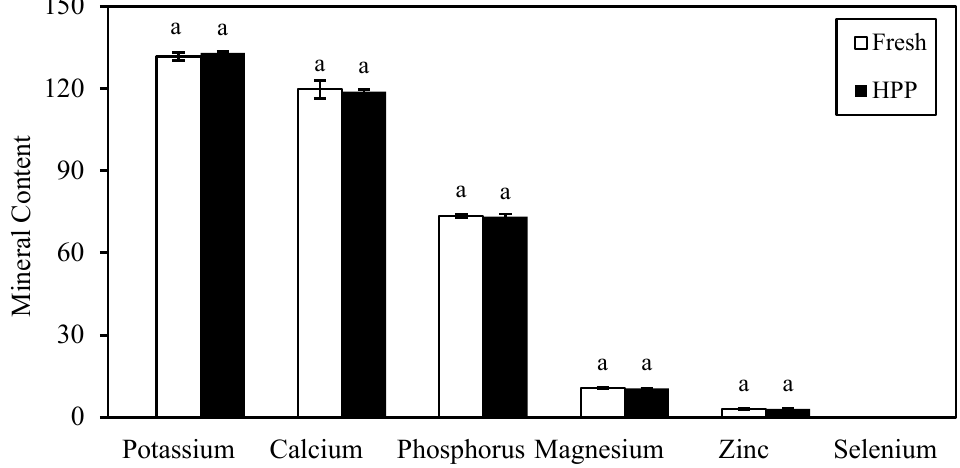
Figure 4. Changes in mineral content of fresh milk after HPP treatment. Potassium, Calcium, Phos- phorus, and Magnesium in unit mg/100mL; Zinc and Selenium in unit mg/kg. Alphabet “a” repre- sent no significant difference between bar at p > 0.05.